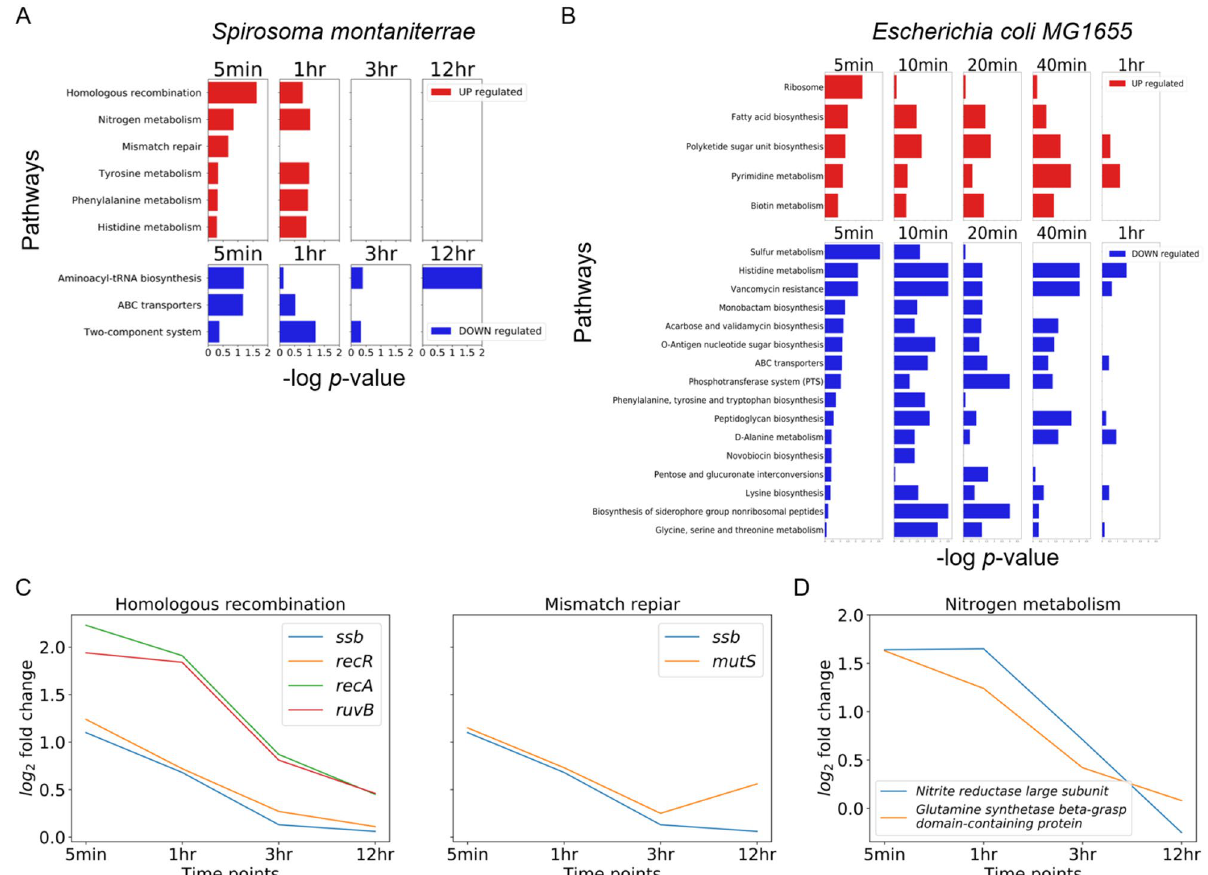
T and Escherichia coli . ( A ) The